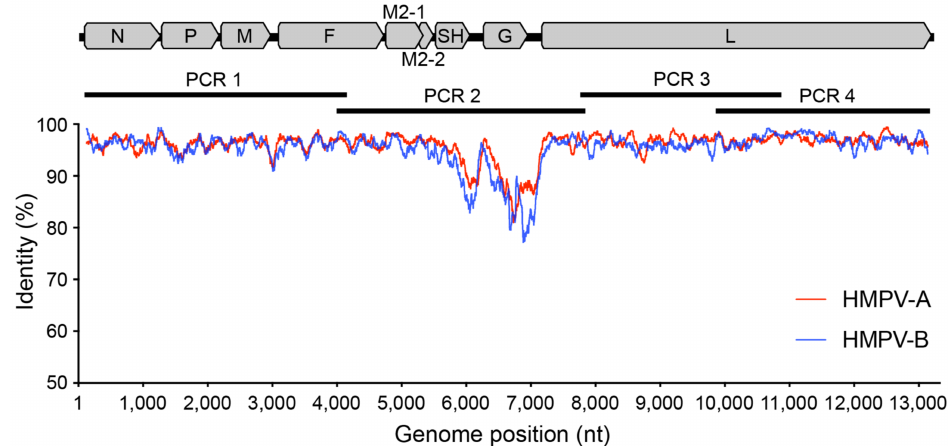
Figure 2. Genetic variability across the HPMV genome. A graphic representation showing the percentage identity at each nucleotide position along the genome with each HMPV subtype plotted separately—A (red) and B (blue). Included also is an HMPV genome shown to scale with annotated genes to highlight primer and amplicon